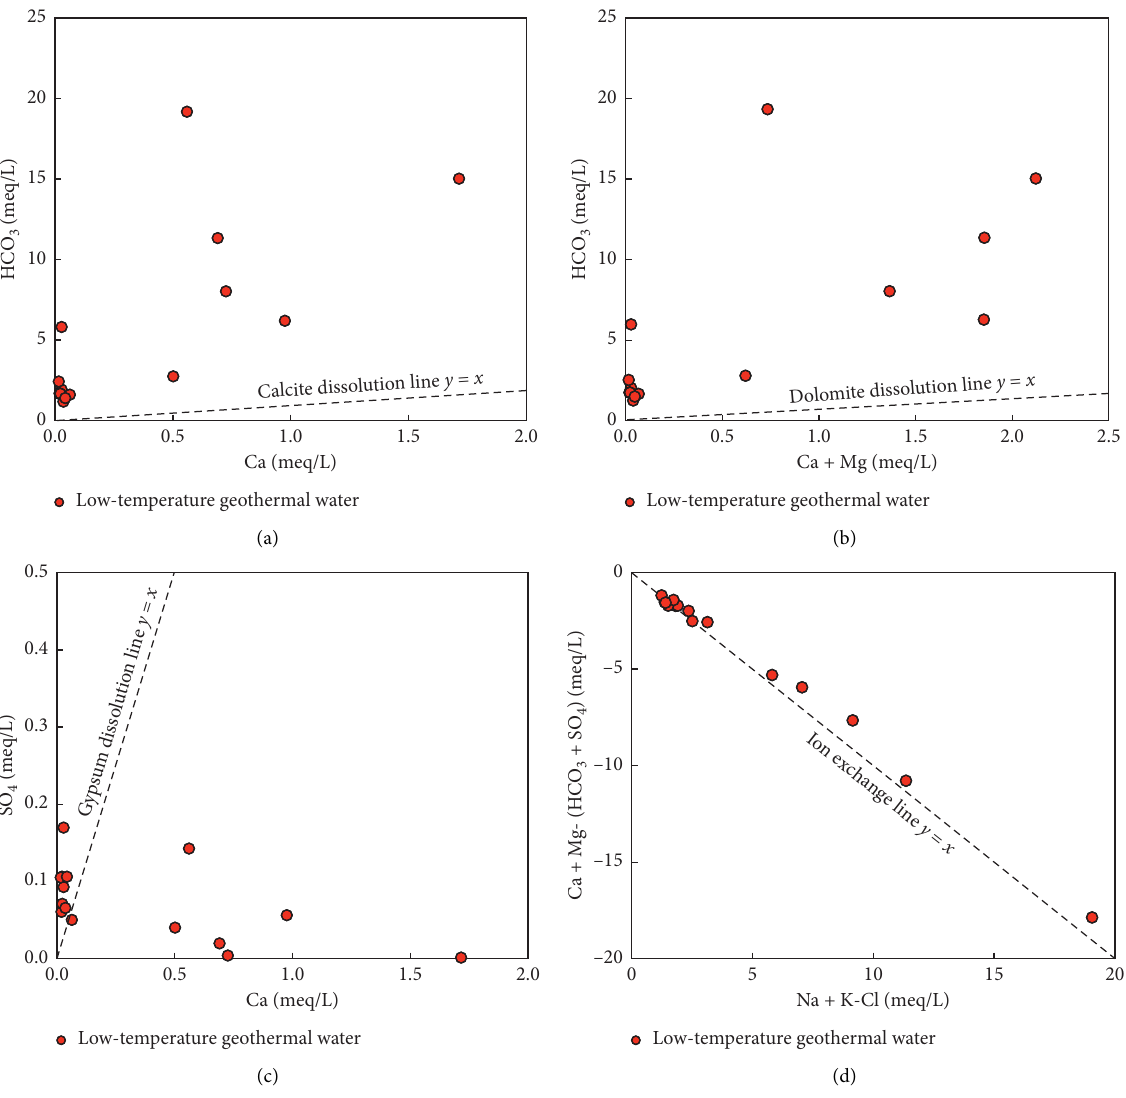
Figure 5: Diagrams used to identify hydrogeochemical processes based on the concentrations of major constituents in water. (a) Ca vs. HCO 3 , (b) Ca+ Mg vs. HCO 3 +SO 4 (c) Ca vs. SO 4 , and (d) Na+K − Cl vs. Ca+Mg − (HCO 3 +SO 4